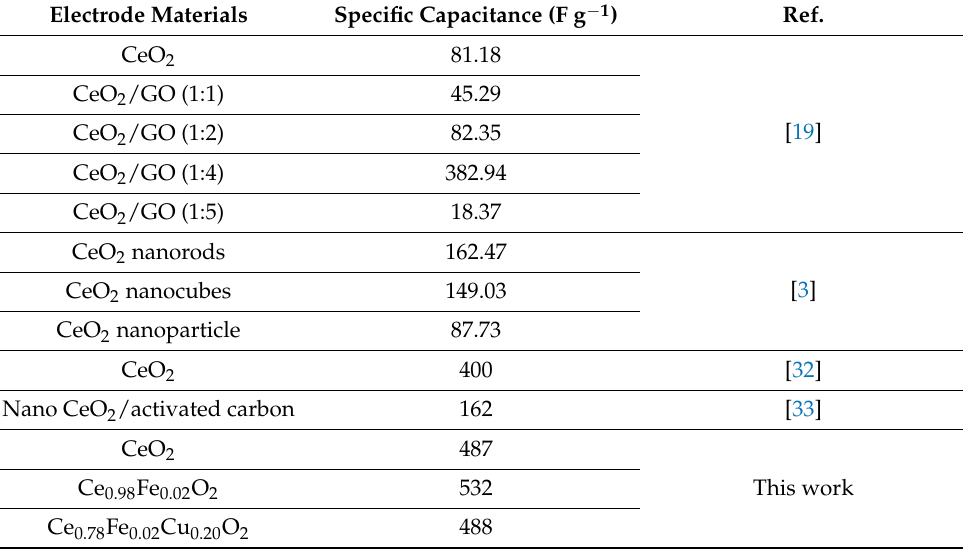
Figure 7. ( a ) CV plots of CeO 2 , Ce 0.98 Fe 0.02 O 2 , and Ce 0.78 Fe 0.02 Cu 0.20 O 2 nanoparticles at scan rate of 10mV S − 1 . ( b ) Variation of specific capacitance of CeO 2 , Ce 0.98 Fe 0.02 O 2 , and Ce 0.78 Fe 0.02 Cu 0.20 O 2 nanoparticles at scan rate of 10mV S − 1 . ( c ) Cyclic performance of Ce 0.98 Fe 0.02 O 2 electrode for 1000 cycles. Table 3. A comparative study of specific capacitance between current work and earlier reports. Electrode